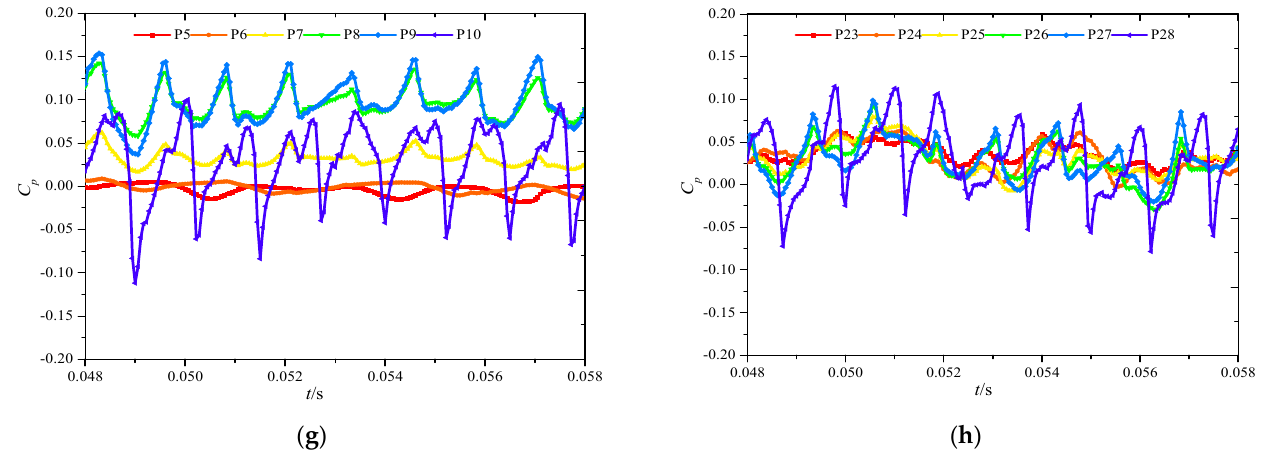
Figure 11. Time domain diagram of the pressure pulsation of the impellers at all levels under cavitation conditions. ( a ) Primary impeller ( NPSH a = 11 m); ( b ) secondary impeller ( NPSH a = 11 m); ( c ) primary impeller ( NPSH a = 9 m); ( d ) secondary impeller ( NPSH a = 9 m); ( e ) primary impeller ( NPSH a = 7 m); ( f ) secondary impeller ( NPSH a = 7 m); ( g ) primary impeller ( NPSH a = 4 m) and ( h ) secondary impeller ( NPSH a = 4 m).